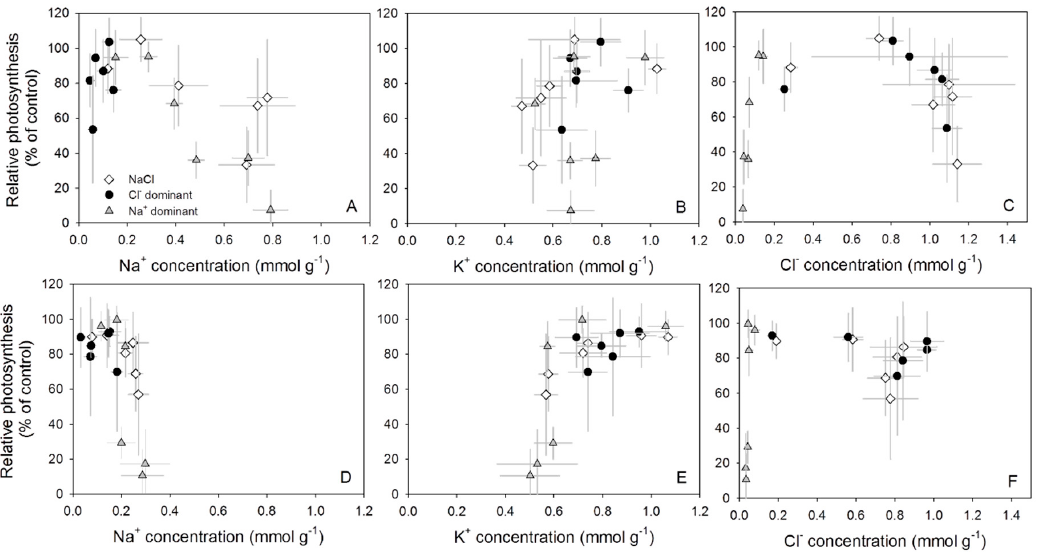
Figure 3. Relationships between ion contents in the leaves (Na + in A , D ; K + in B , E ; Cl − in C , F ) and relative photosynthesis (% of control plants) of cucumber genotypes Aramon (A,B,C) and Line-759 (D,E,F) in experiment 1. Values are means ± SD ( n = 5).